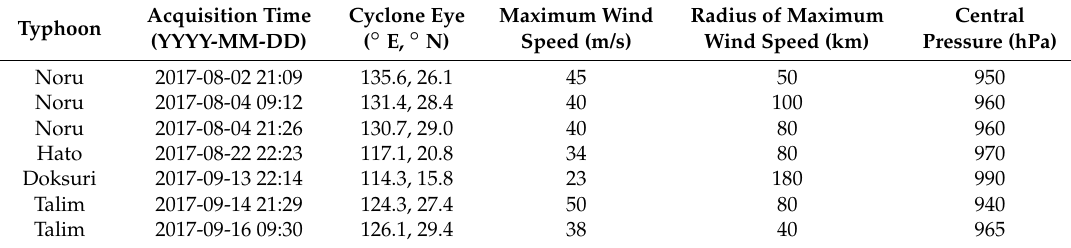
Table A1. Information of seven VH-polarization GF-3 SAR images and corresponding